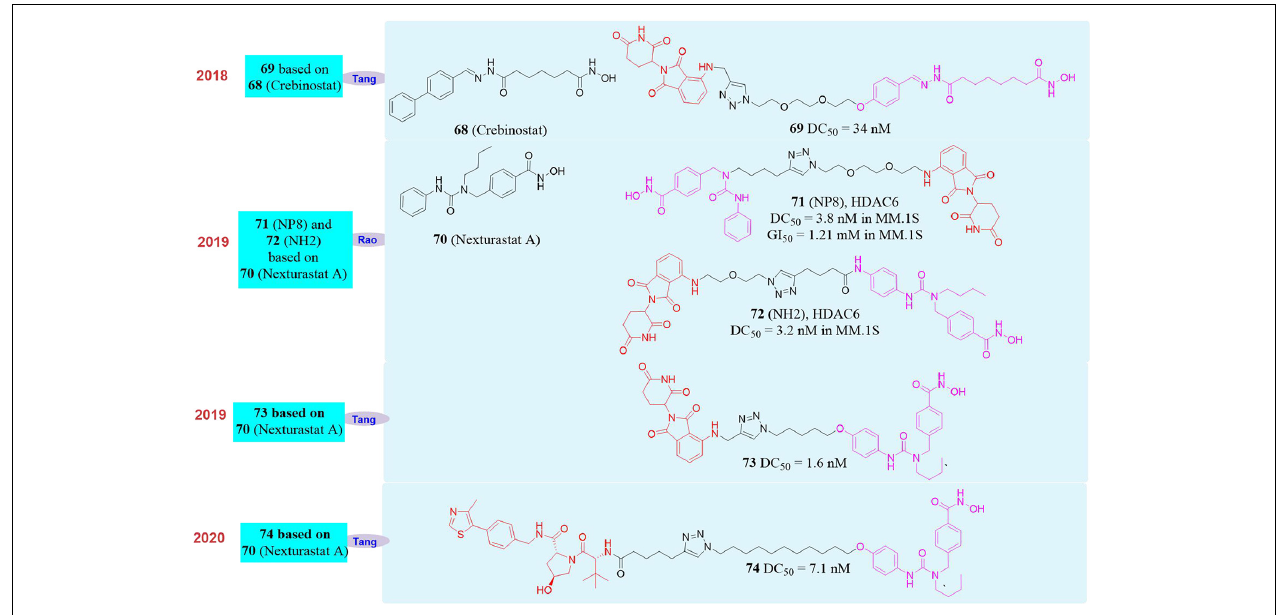
FIGURE 12 | Structures of HDAC6 inhibitors and